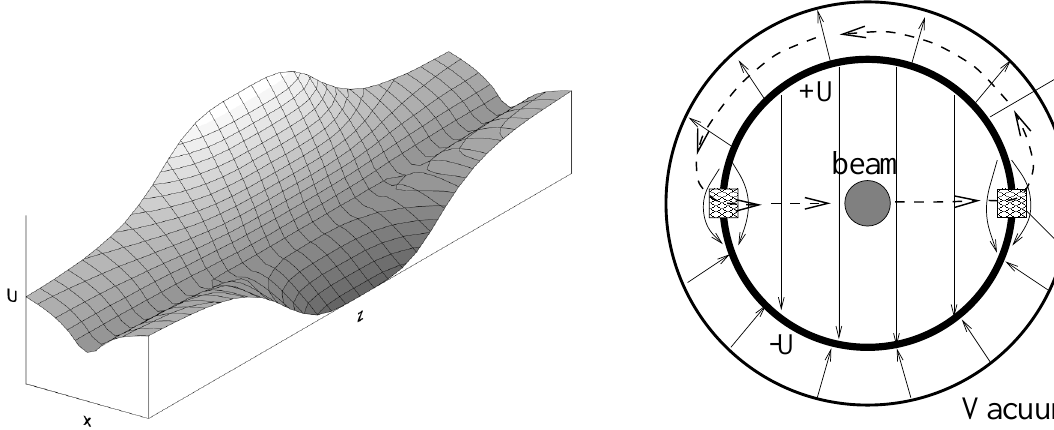
FIG. 9. Changing of the electron beam potential well by the cleaning electrode.